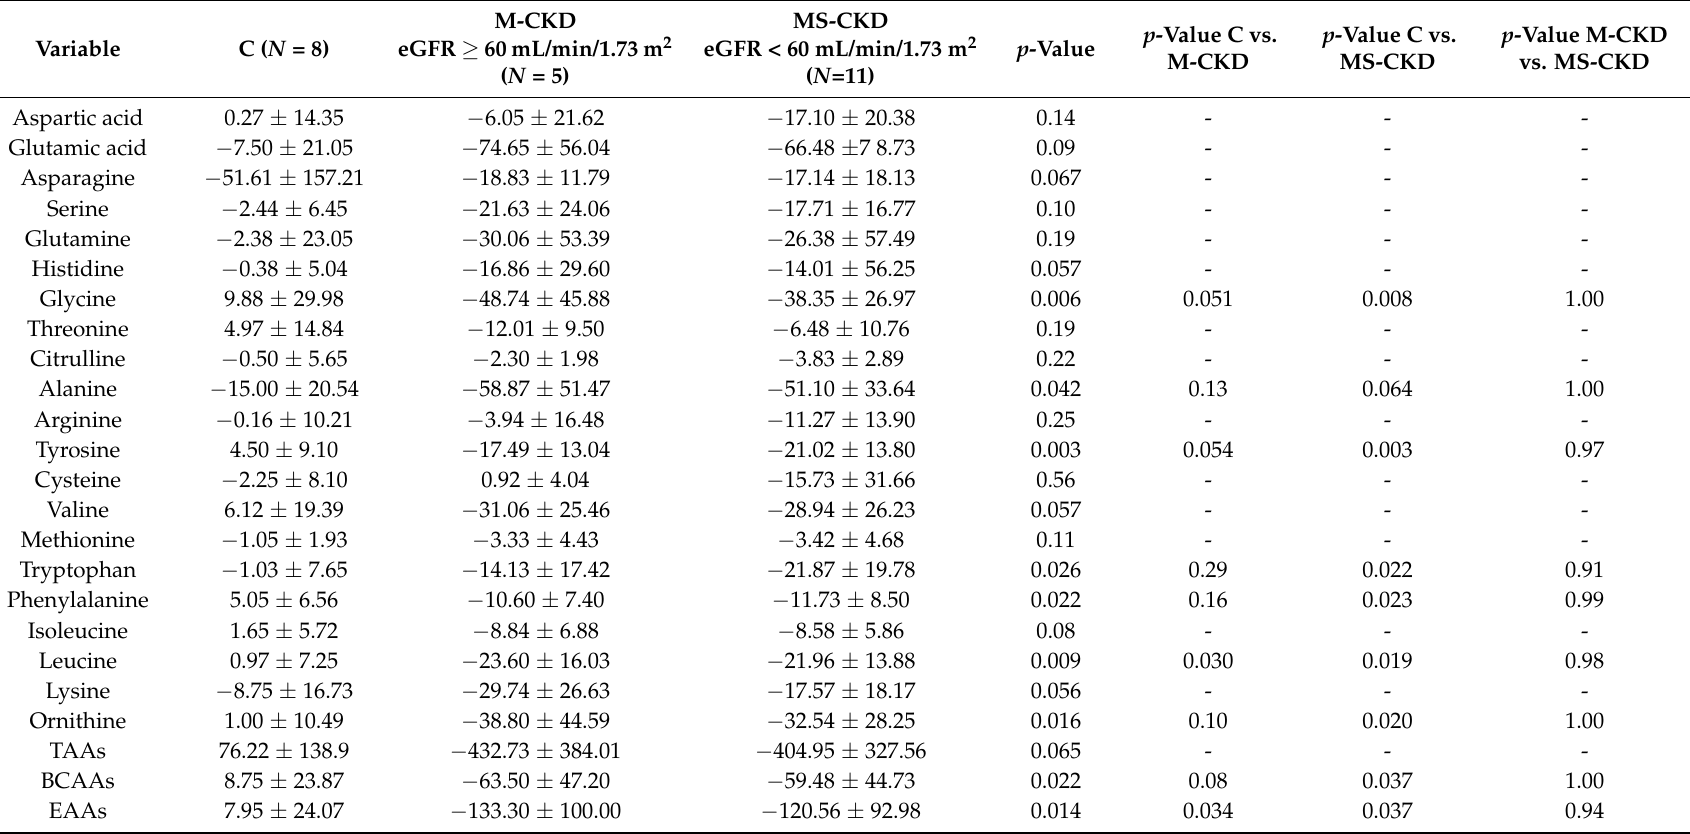
Table 8. (A-V) AA differences ( µ mol/L) in controls (C) and cardiorenal syndrome type 2 (CRS 2) patients after stratification for eGFR ≥ 60 mL/min/1.73 m 2